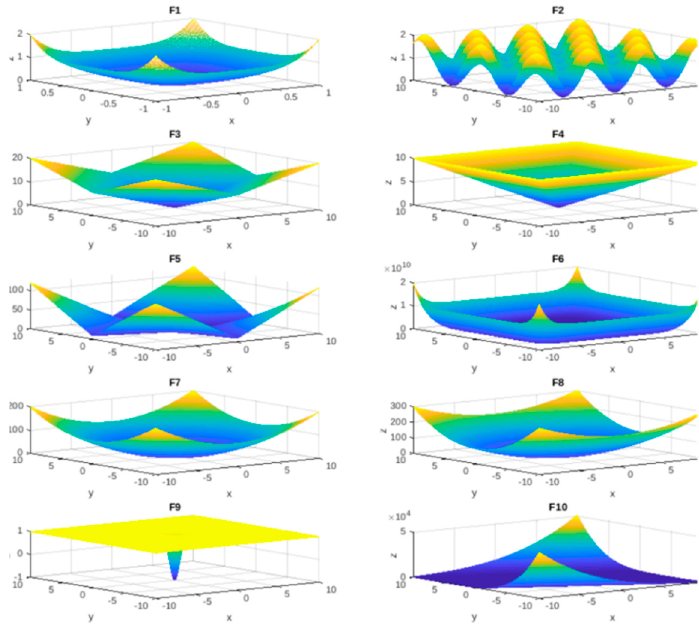
Figure A1. Testbench Unimodal functions.